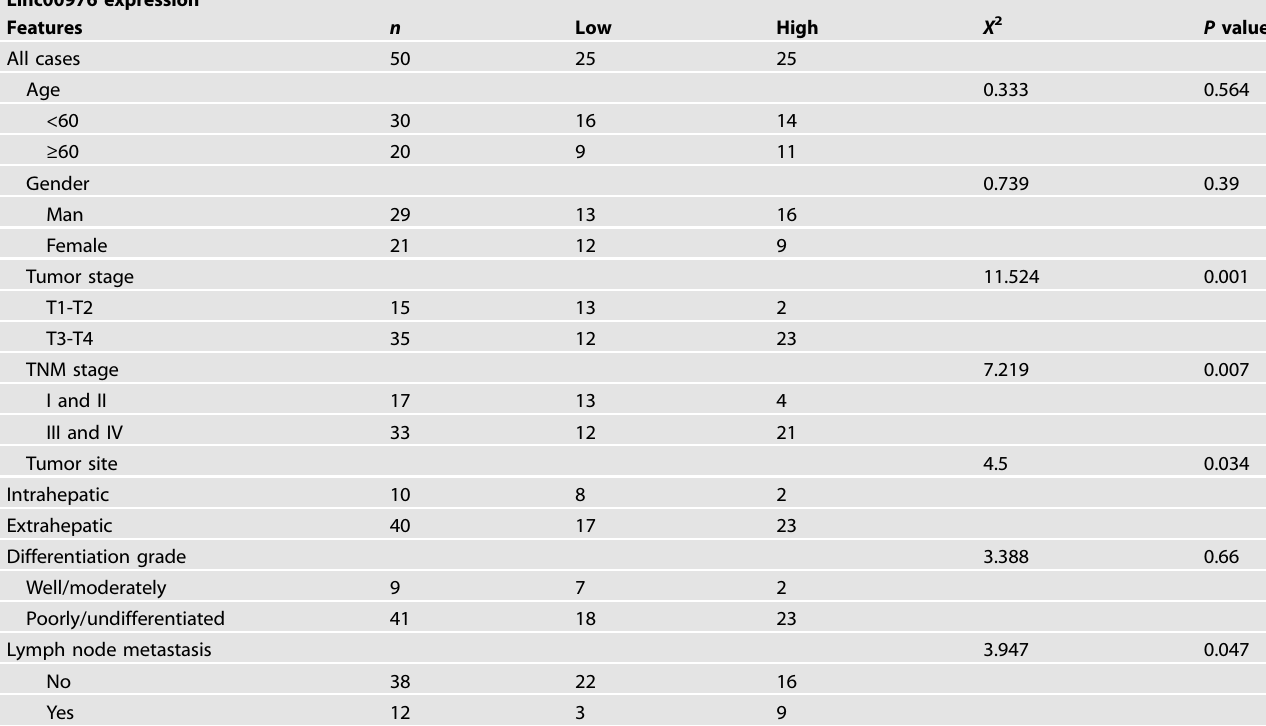
Table 1. Correlation between clinicopathological characteristics and linc00976 expression